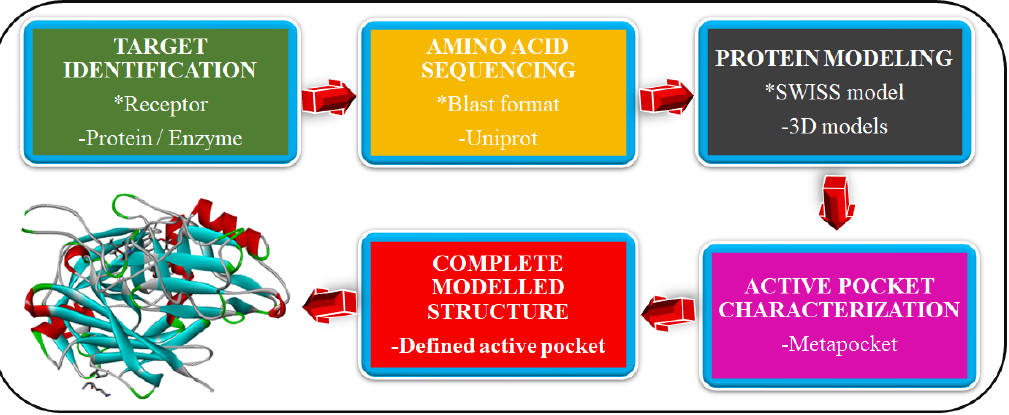
Figure 4. In-house stages employed in homology modeling of target proteins with defined binding